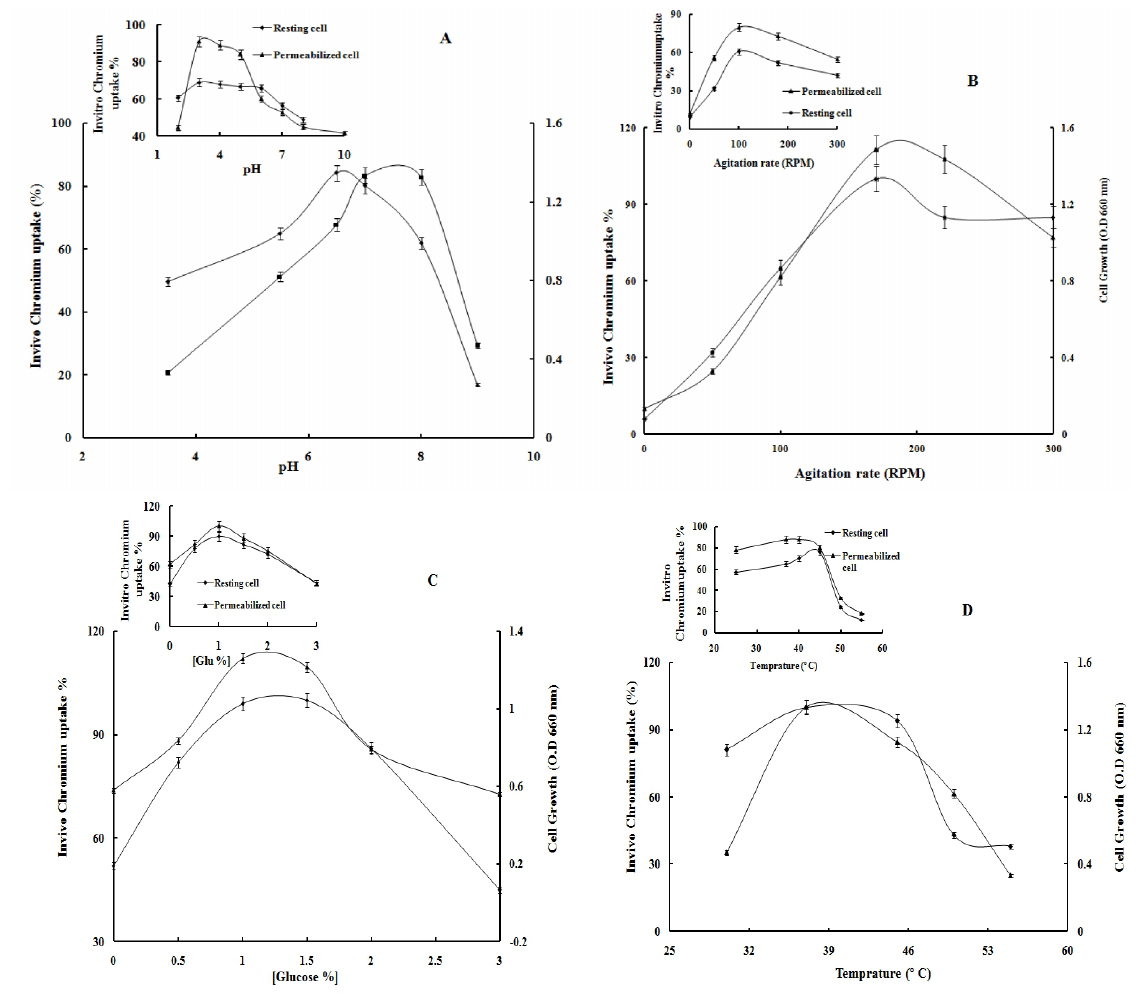
Fig. 5. Influence of pH (A), aeration level (B), glucose as an electron donor concentration (C) and incubation temperature (D) on Cr(VI) bio-reduction by Alcaligenes sp . strain